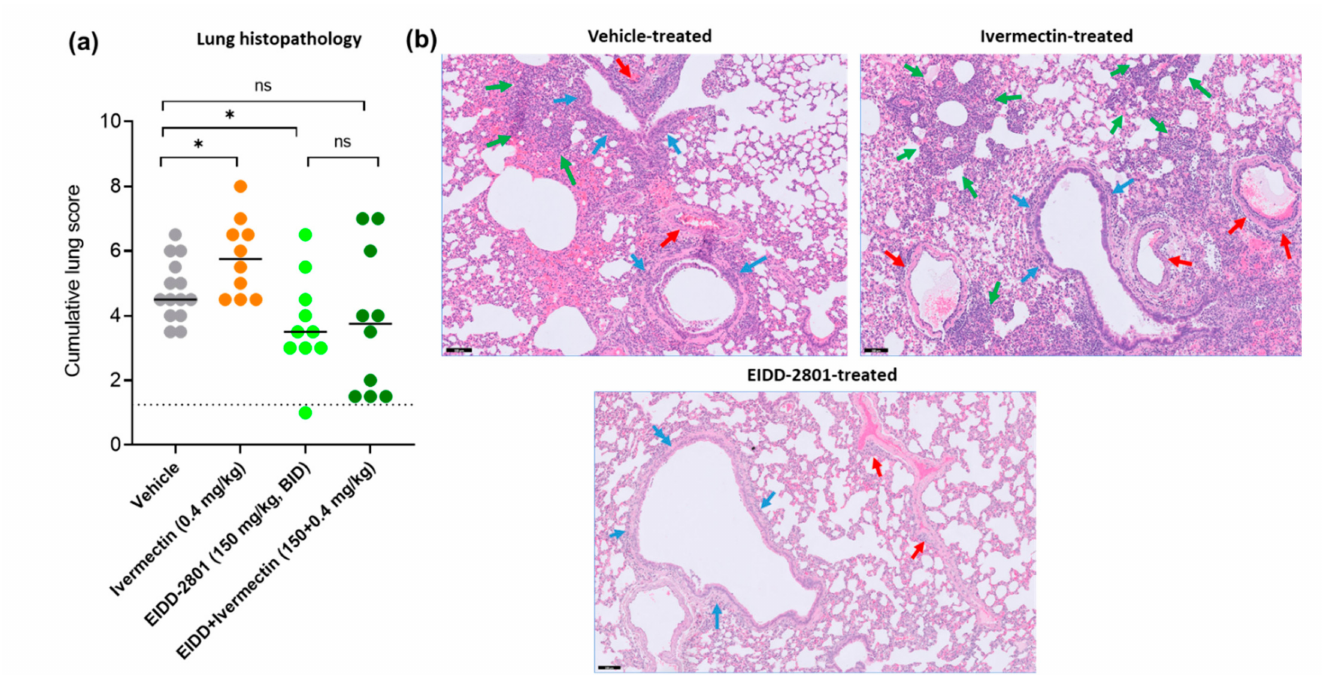
Figure 2. Lung histopathology of SARS-CoV-2-infected Syrian hamsters following treatment with ivermectin as a single or combination therapy. ( a ) Cumulative severity score from H&E stained slides of lungs from control (vehicle-treated ivermectin-treated (0.4 mg/kg, QD), EIDD-2801-treated (150 mg/kg, BID) and combination-treated (EIDD-2801+ivermectin at 150 mg/kg BID+0.4 mg/kg QD) SARS-CoV-2 (B.1.351)-infected hamsters at day 4 post-infection (pi). Individual data and median values are presented, and the dotted line represents the median score of untreated non-infected hamsters. Data were analyzed with the Mann − Whitney U test. * p < 0.05, ns = non-significant. Data are from two independent experiments with n = 14 for vehicle group and n = 10 for the other groups. EIDD = EIDD-2801. ( b ) Representative H&E images of lungs of control (vehicle-treated), ivermectin- treated and EIDD-2801-treated SARS-CoV-2 (B.1.351)-infected hamsters at day 4 post-infection (pi). Lung from vehicle control group showed peribronchial inflammation with intrabronchial cell debris (blue arrows), perivascular inflammation with endothelialitis (red arrows), and bronchopneumonia (green arrows) surrounded by intra-alveolar hemorrhage. Image of the lung from the ivermectin- treated animal showed severe perivascular inflammation with vasculitis (red arrows), limited and focal peri-bronchial inflammation (blue arrows), and significant and multifocal bronchopneumonia (green arrows). On the other hand, the lung from the molnupiravir-treated animal (EIDD-2801) revealed very limited peribronchial (blue arrows) and peri-vascular (red arrows) inflammation. Scale bar 100 µ